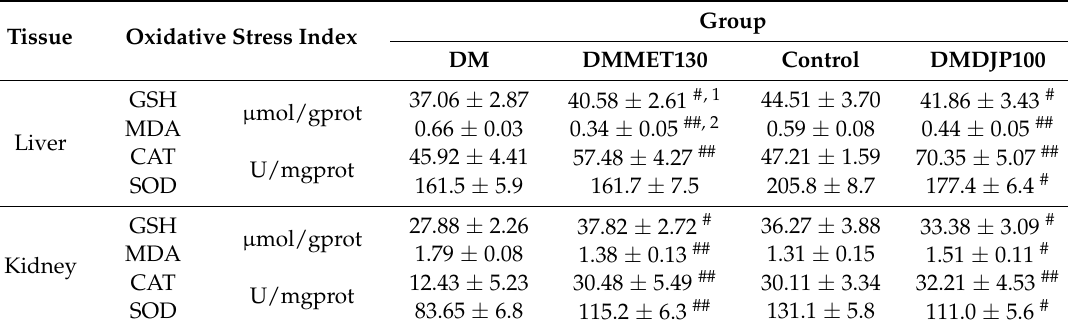
Table 4. Oxidative stress index of liver/kidney tissue in the mice.